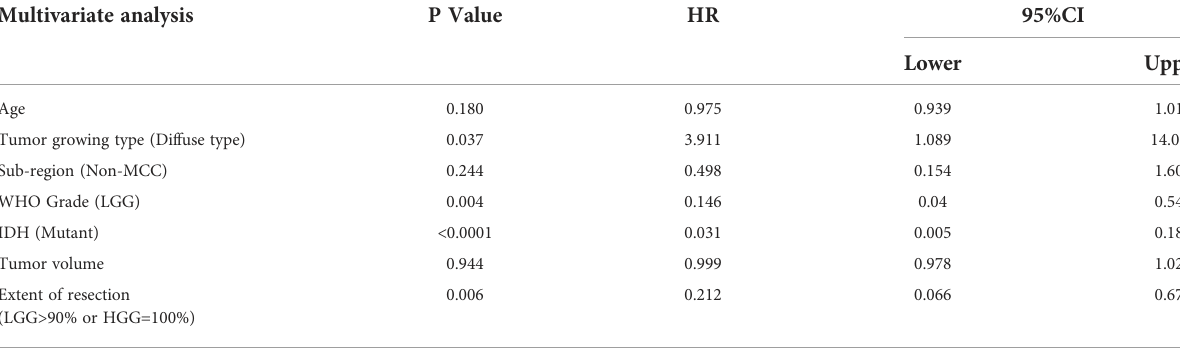
TABLE 7 Multivariate analyses of overall survival outcome in CG